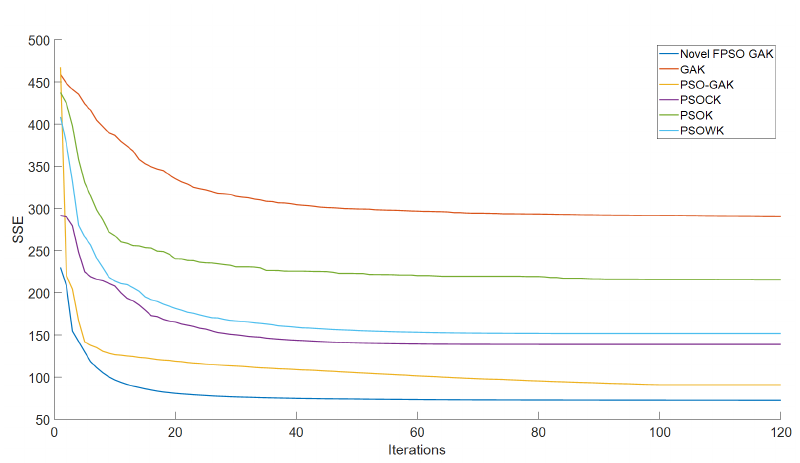
Figure 7. The SSE convergence curve for the searching optimal initial clustering centers stage of taxi GPS dataset from Roma